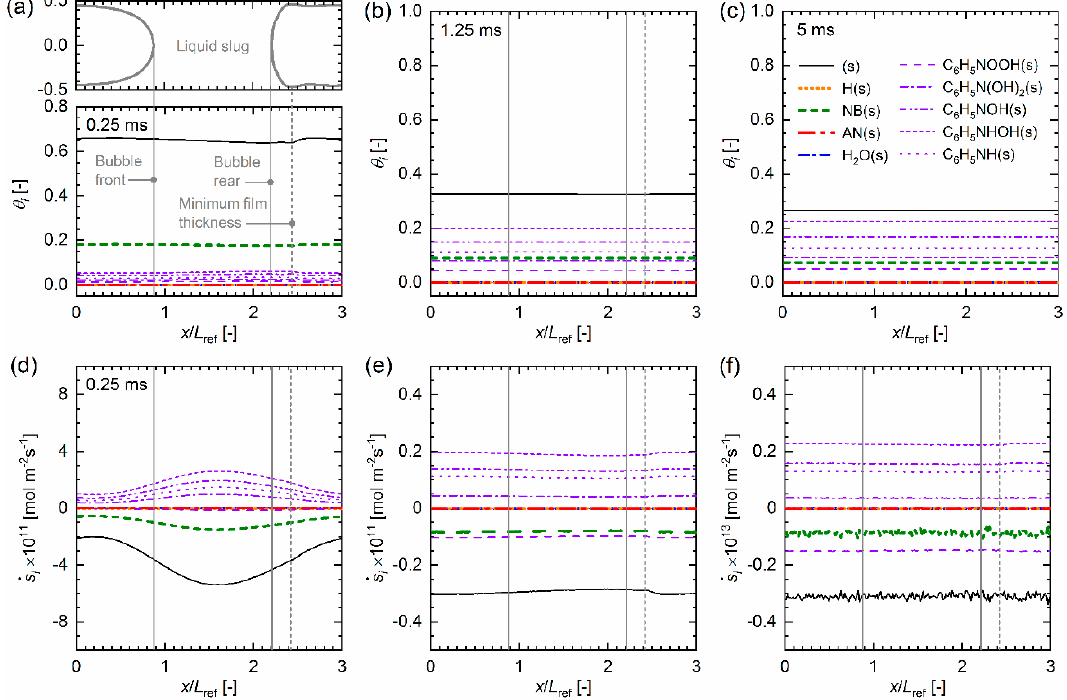
Figure 8. Axial distributions of site fractions ( a – c ) and production/consumption rates ( d – f ) of surface species at t = 0.25, 1.25 and 5 ms. For legend see inset in subfigure ( c ).